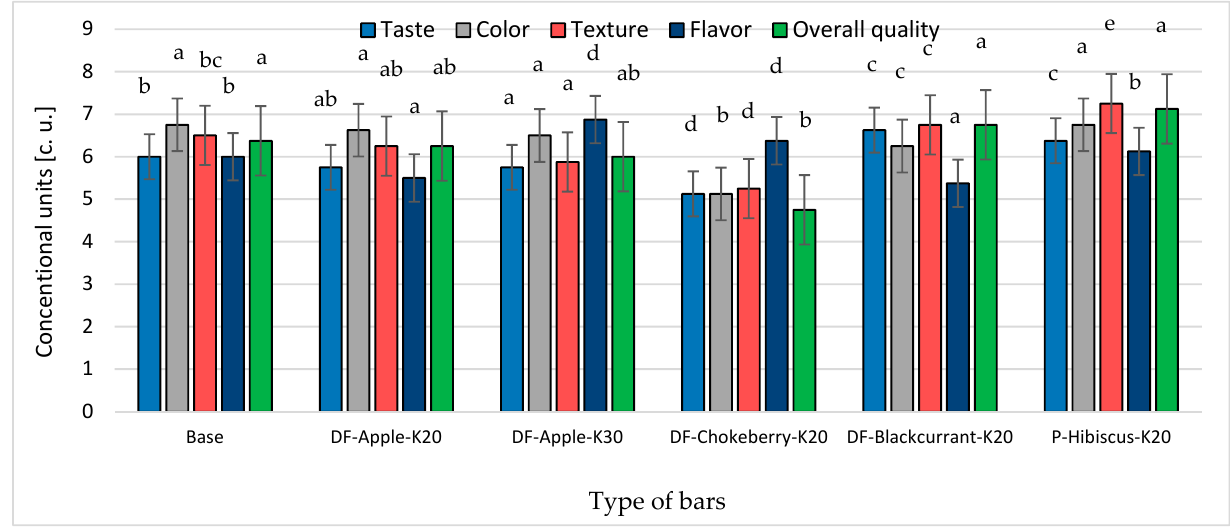
Figure 5. The effect of kale and fibre preparation or powder of dried hibiscus flower addition on sensory properties of multigrain bars. Designations: a, b, c—homogeneous groups (the influence of type of bars) at α = 0.05. The bar codes are explained in Table 4.